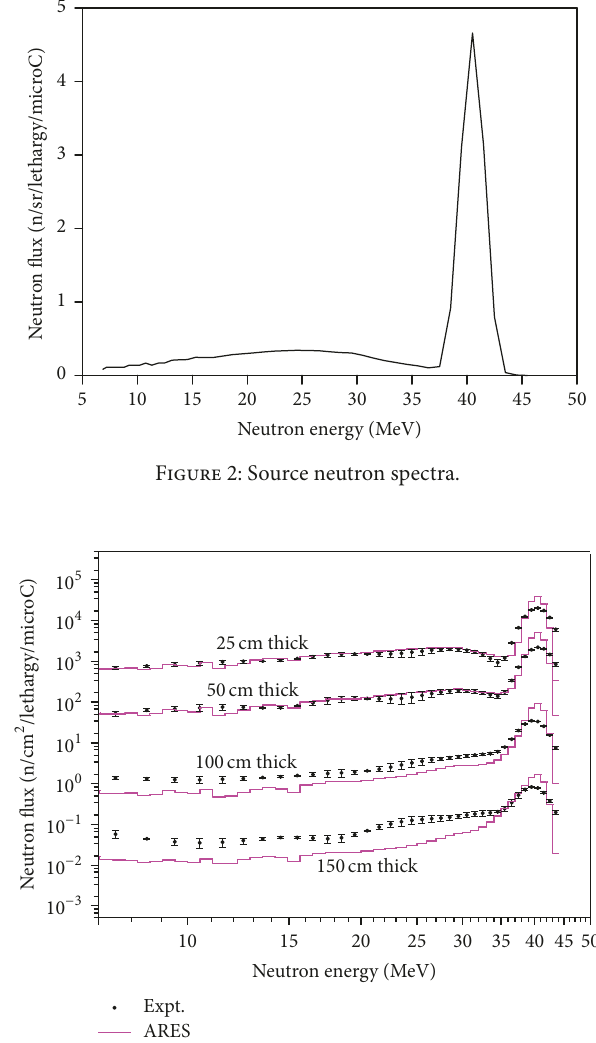
Figure 3: Measured and calculated neutron spectra of the concrete